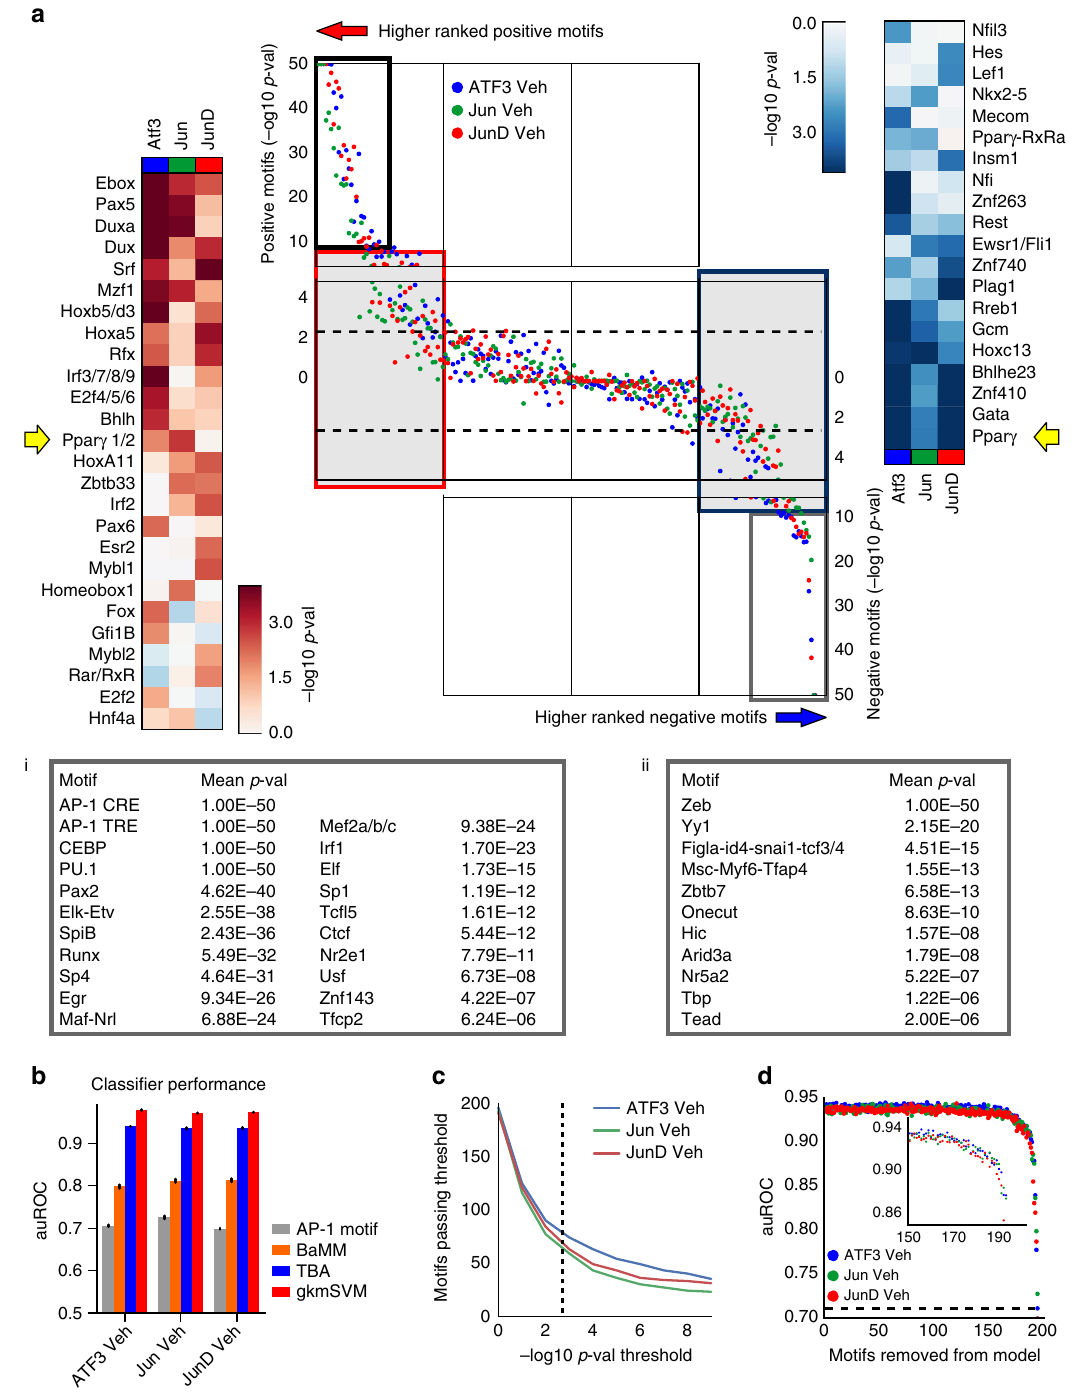
Fig. 4 Transcription factor binding analysis (TBA) identi fi es motifs predicted to specify differential AP-1 monomer-binding in resting thioglycollate elicited macrophages. a DNA motifs rank order based on the signi fi cance of the motif according to the likelihood ratio test. The black box represents the most signi fi cant motifs positively correlated with binding for all AP-1 monomers and are listed in (i) and the most signi fi cant motifs negatively correlated with binding for all AP-1 monomers are shown in the gray box and are listed in (ii). The signi fi cance of motifs positively correlated with binding that show a 100- fold likelihood difference between two monomers are shown on the left heatmap (red); the right heatmap (blue) gives the signi fi cance of corresponding motifs negatively correlated with binding. b Comparison of the performance of TBA against the AP-1 motif score alone, Bayesian Markov Model (BaMM) motif score, and gapped k-mer SVM as measured by the area under the receiver operating characteristic curve (auROC). Error bars indicate the standard deviation of auROC across 5 cross-validation sets. c Number of motifs that pass an in-silico mutagenesis test for signi fi cance (the likelihood ratio test comparing the performance of a full model that uses all the motifs and a mutated model with one motif removed) at various p -value thresholds. d Predictive performance of TBA when predicting ATF3, Jun, and JunD binding as motifs are iteratively removed starting from the least important motif based on the weights calculated by TBA. Inset shows performance values beginning at 150 motifs removed where predictive performance begins to